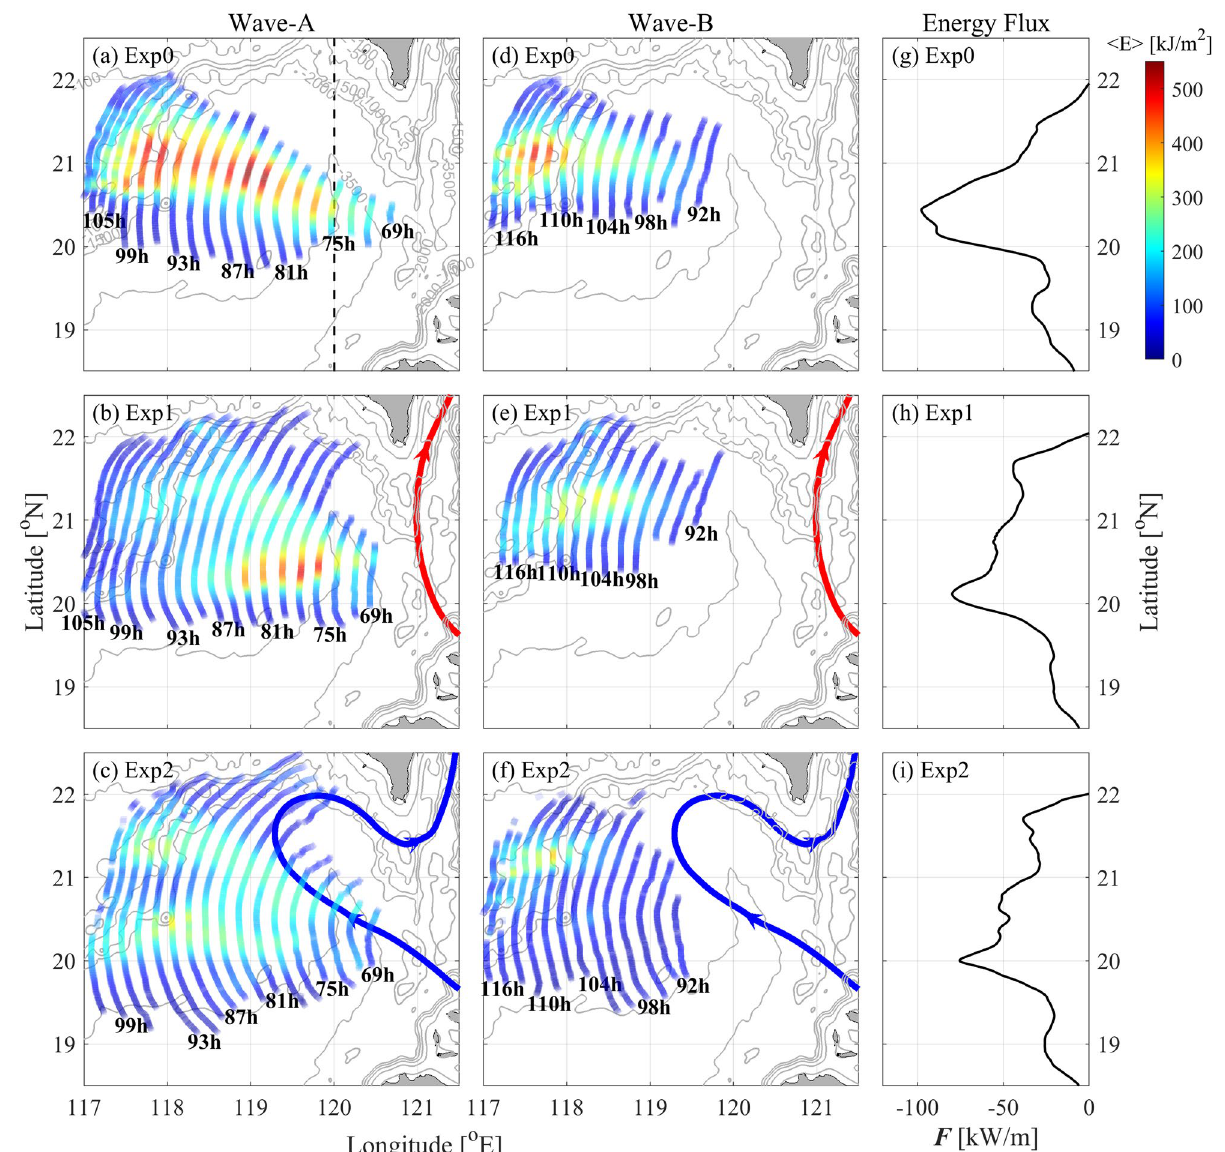
Figure 8. Wave energy (shadings, units: kJ/m 2 ) along the crest lines of the A-wave and B-wave in ( a,d ) Exp0, ( b,e ) Exp1and ( c,f ) Exp2. Depth-integrated zonal baroclinic energy flux along 120°E (black dashed line in a ) are shown in ( g–i ). Grey contours in the subfigures denote the isobaths. The leaping and looping paths of the Kuroshio are marked by red and blue curves,